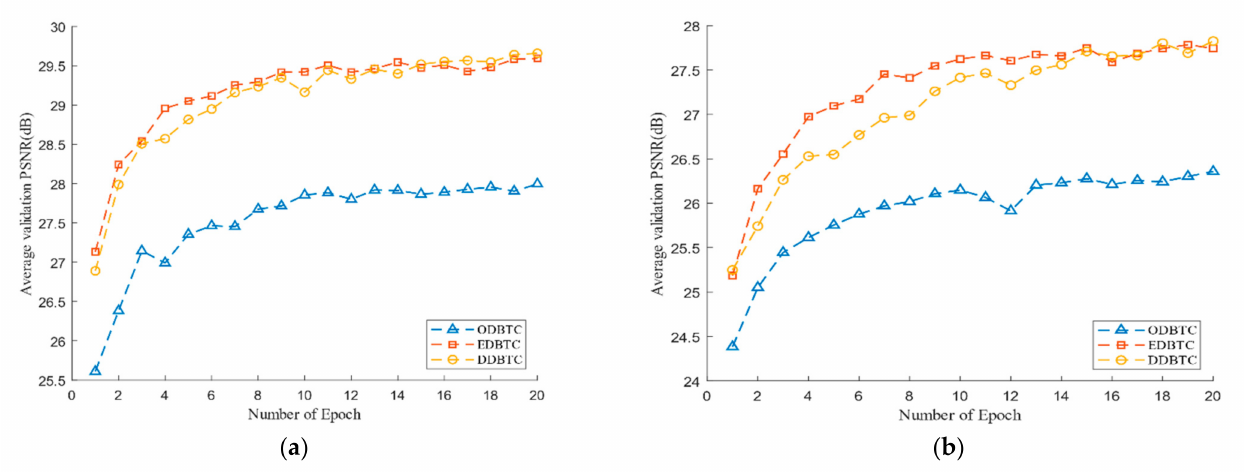
Figure 9. The performance of the proposed method in terms of average peak signal-to-noise (PSNR) values during the training process over various H-BTC image block sizes: ( a ) 8 × 8, ( b ) 16 ×